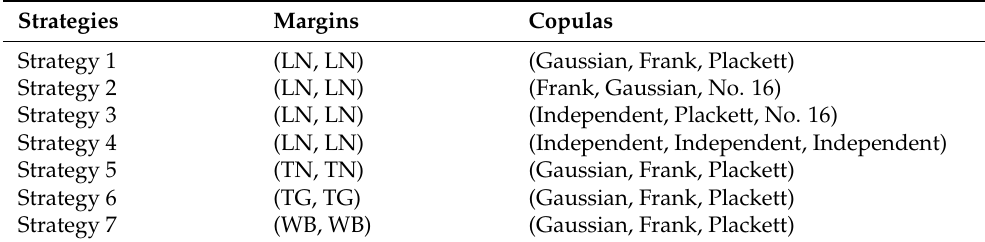
Table 7. Simulation strategies of multi-layer